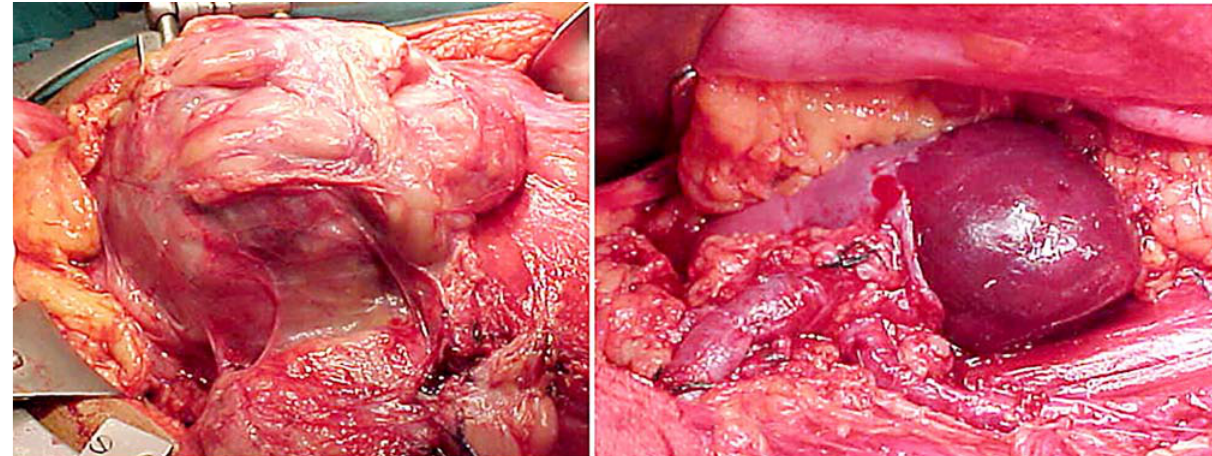
Figure 3 – Intraoperative view of case 1 (before and after removal) showing encapsulated tumor overlying and surrounding the kidney.